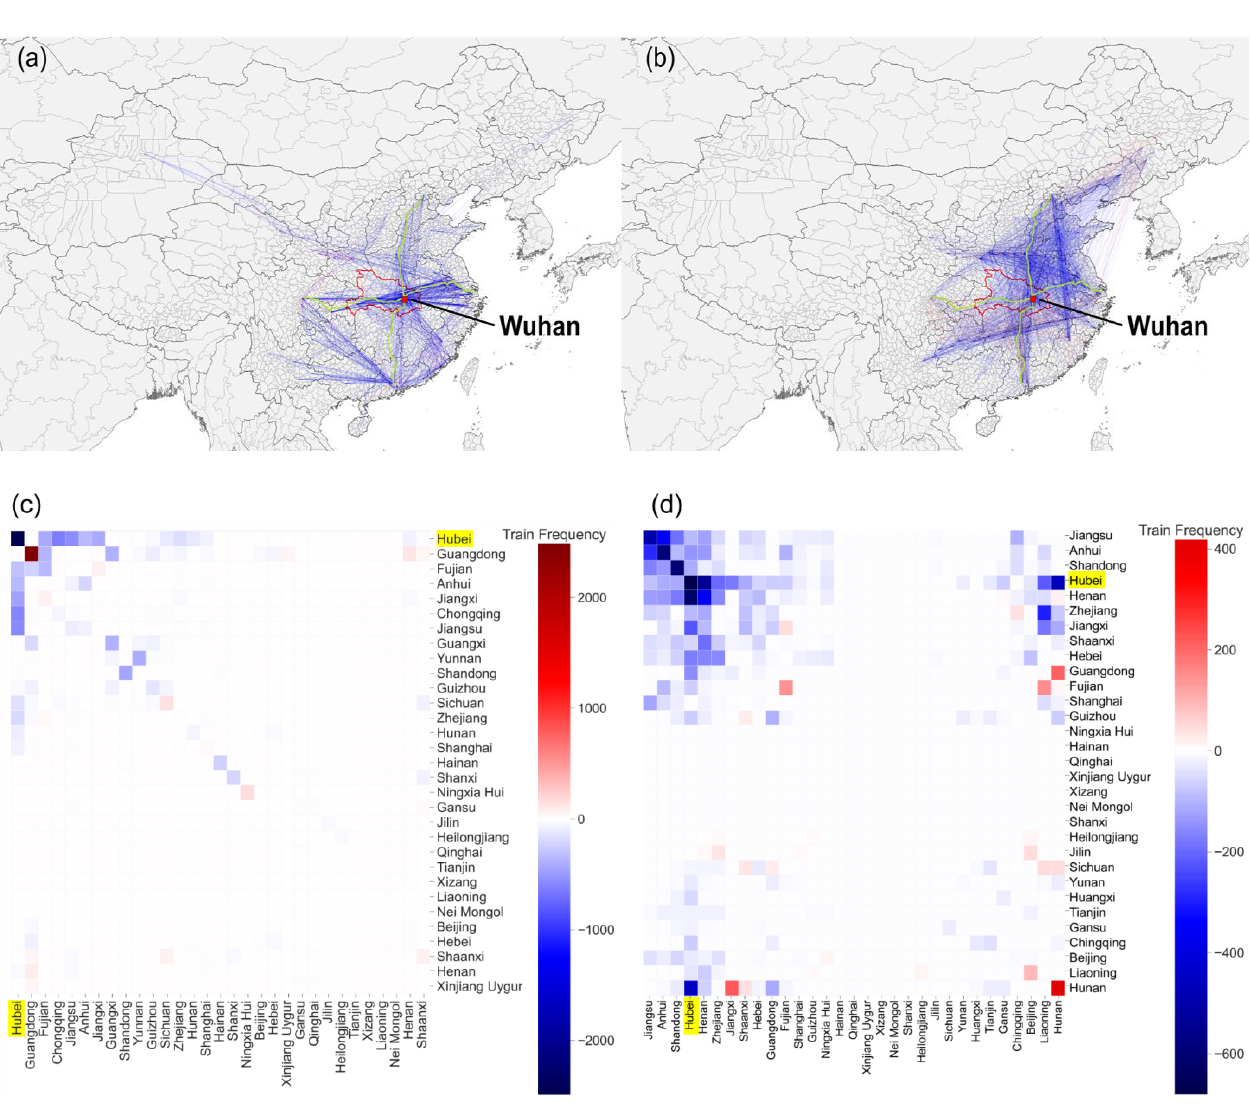
Figure 2. The changes in train frequency in the OD network after the Wuhan city lockdown at the city and province